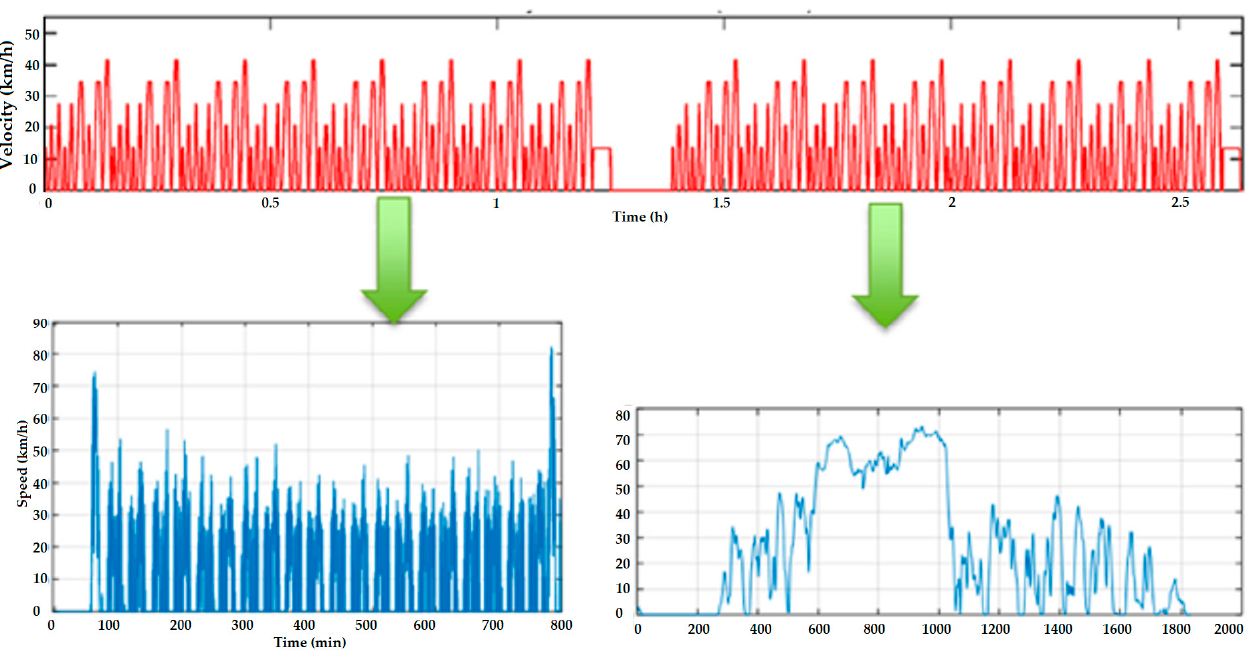
Figure 2. Comparison between the measured driving cycle from the demonstrations and standard driving cycles.